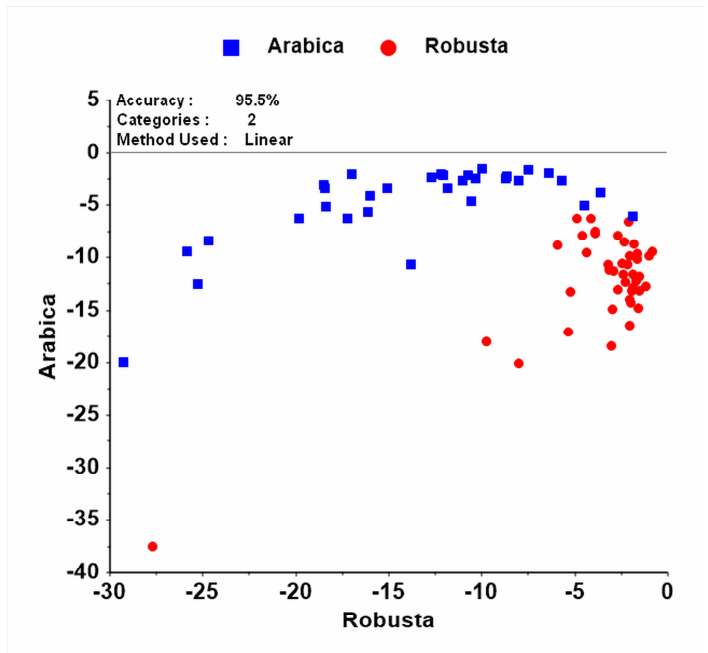
Figure 5. Discrimination among coffee species by linear discriminant analysis (LDA) using selected wavelengths derived from NIR spectroscopy as predictor variables ( n = 74 samples).